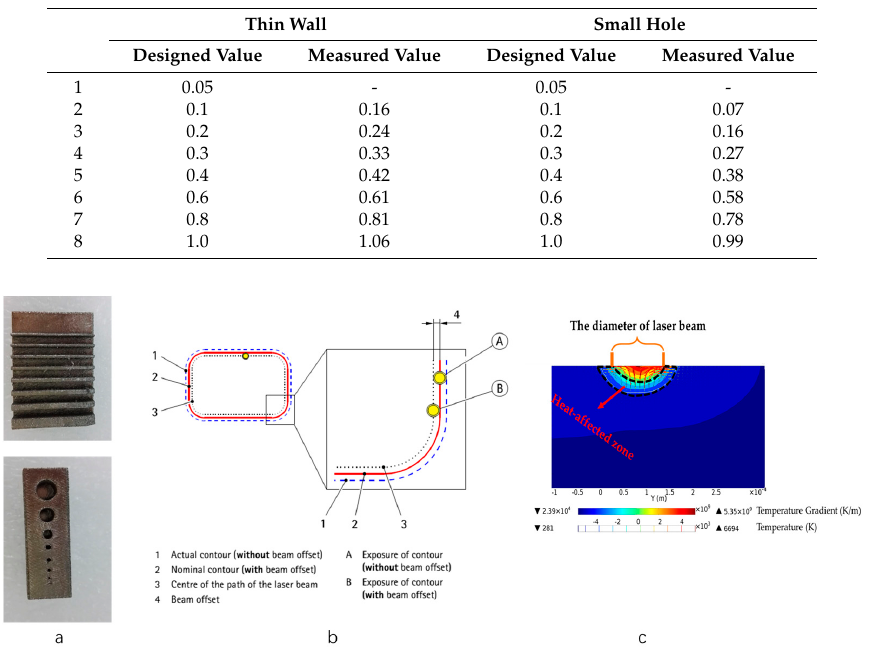
Figure 8. ( a ) Specimens of the thin walls and small holes; ( b ) Beam offset on exposure of the contour; ( c ) Generation of heat affected zone during SLM process.